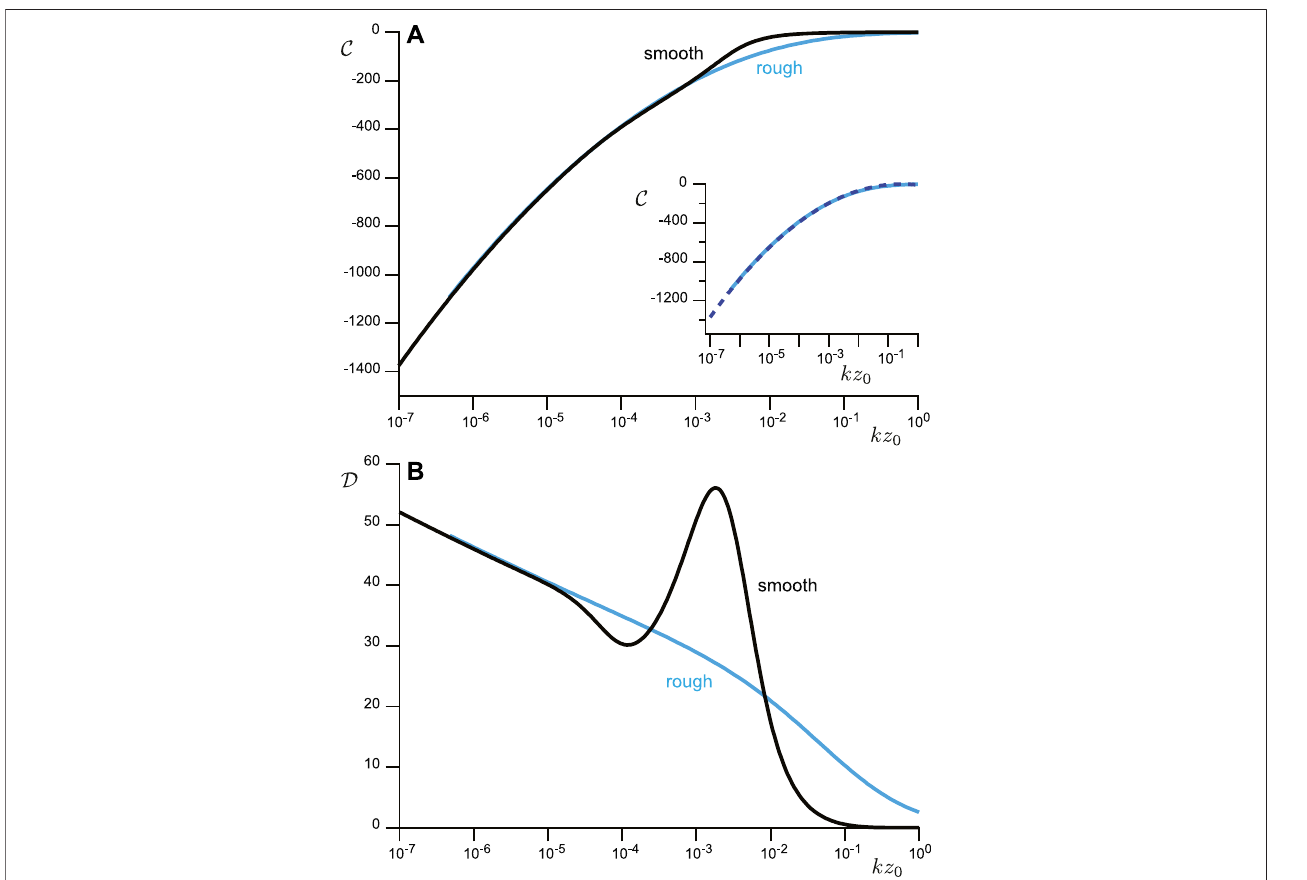
FIGURE 1 | Basal pressure coef fi cients in terms of the rescaled wavenumber k × z 0 from predictions in [51]. Panel ( A ): in-phase component C . Panel ( B ): in- quadraturecomponent D .Bluelines:roughbed casewithroughness z 0 (cid:2) r × d and R d ≫ 1,calculatedfrom[9,10].Blacklines:smoothbedcase R d → 0,forwhichthe effective bed roughness in the logarithmic region is proportional to viscous length [27, 51]. Blue and black lines collapse at small wavenumbers adjusting the roughness proportionaltotheviscouslength: z 0 (cid:2) ] / ( 7 u * ) .Insetofpanel( A ):comparisonoftheroughcase[9,10]andthequadratic fi t C (cid:2) −( 1 / κ 2 ) ln 2 ( 2 π b / kz 0 ) ,with b x 0 . 04 (dashed